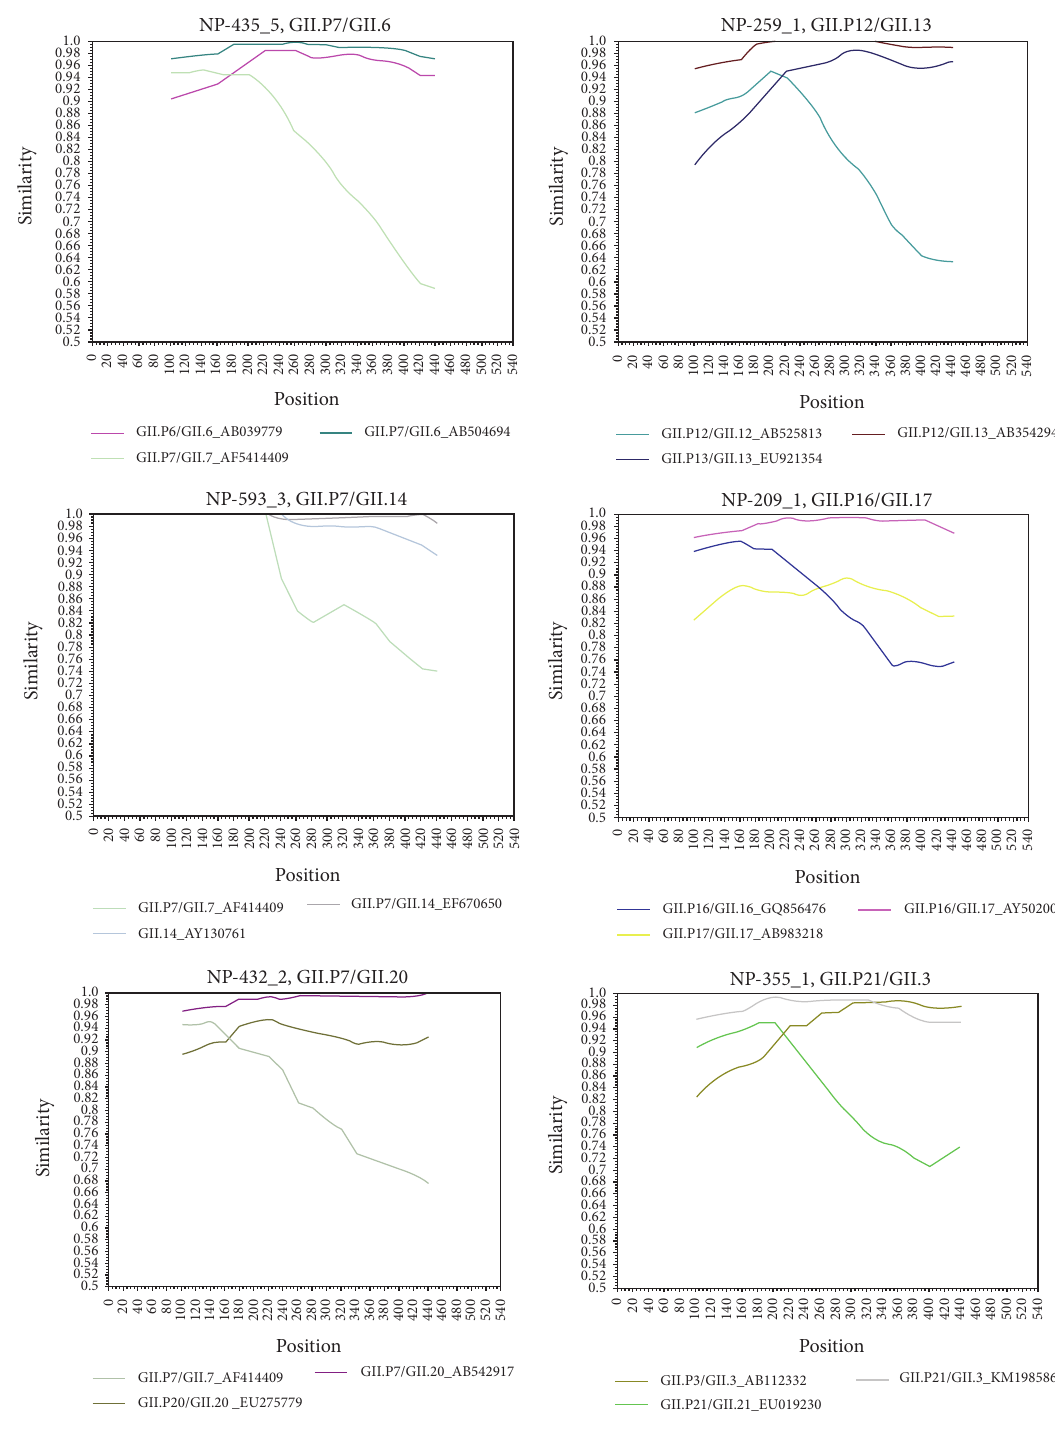
Figure 3: Representative plots of Simplot analysis of each norovirus recombinant. The 𝑦 -axis indicates a degree of similarity between query recombinant and recombinant and two nonrecombinant parental norovirus strains. Sample name and recombination genotype are located on top of each plot. Samples names are indicated as NP ###-# for case and NPC ###-# for control. # after the sample name indicates colony number of clone for that sample. Nonrecombinant parental strains used are GII.P3/GII.3-AB112332, GII.P6/GII.6-AB039779, GII.P7/GII.7-AF414409, GII.P12/GII.12-AB525813, GII.P13/GII.13-EU921354, GII.14-AY130761, GII.P16/GII.16-GQ856476, GII.P17/GII,17- AB983218, GII.P20/GII.20-EU275779, and GII.P21/GII.21-EU019230. Recombinant parental strains used are GII.P7/GII.6-AB504694, GII.P7/GII.14 EF670650, GII.P7/GII.P20-AB542917, GII.P12/GII.13-AB354294, GII.P16/GII.17-AY502009, and